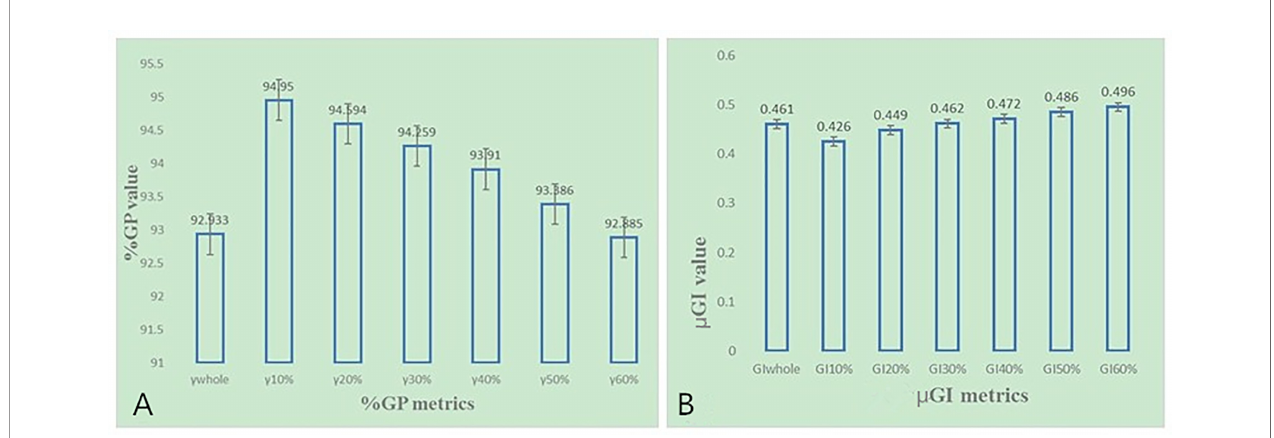
FIGURE 6 | (A) The %GP in different regions based on 3%/2 mm criteria for NPC patients. (B) The m GI in different regions based on 3%/2 mm criteria for NPC patients.